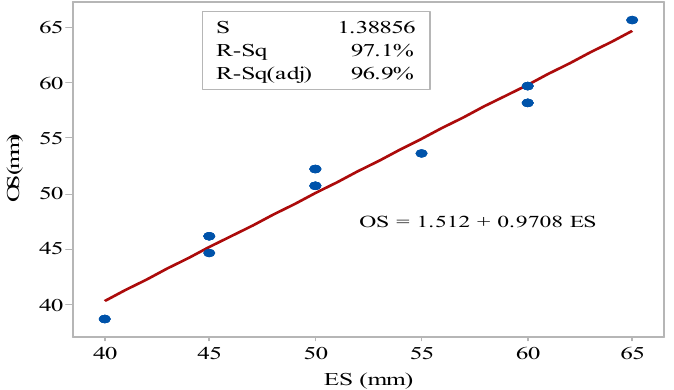
Figure 8. Correlation between optimisation slump (OS) and experimental slump (ES).